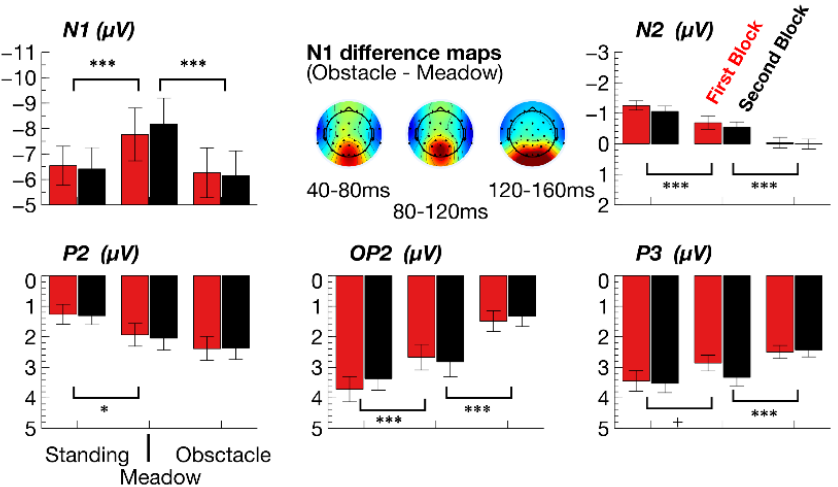
Figure 4. Amplitudes of the eye-blink-related EEG potentials (mean and standard error of means) and topographical plot for the comparison of the two walking conditions around the latency of the N1. This component was largest while walking on meadow. As the difference maps show, the reduction for mastering the obstacle course was clearly located over early visual areas. The anterior N2, the occipital P2 (OP2), and the P3 steadily decreased in amplitude with increasing walking complexity. The parietal P2 showed and inverse effect. The similarity across blocks clearly demonstrates the high reliability of these measures. Significant effects of walking condition are depicted for all pairwise comparisons (***: p < 0.001; *: p < 0.05; +: p < 0.1).